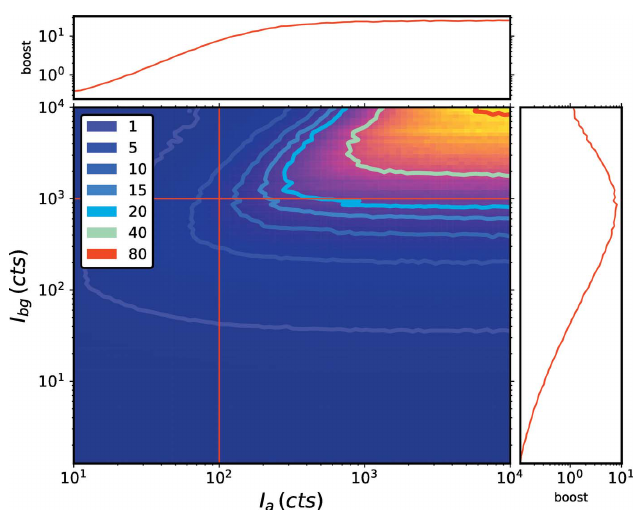
Figure 5 We define a boost factor as the ratio of the signal to noise obtained with coherent amplification to that obtained without using an amplifier. The boost factor thus quantifies the experimental gain that can be achieved by exploiting X-amp. The plot false color map shows the boost factor for simulations using constant scattering of the sample (10 counts s (cid:3) 1 in the data shown), but varying the scattering intensity of the background ( I and amplifier ( I a